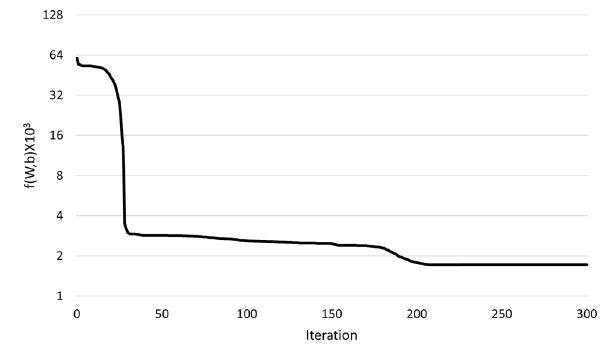
Figure 10. An example of convergence of objective function with iteration during optimization— Network N1, Material M2, and observation period of 180